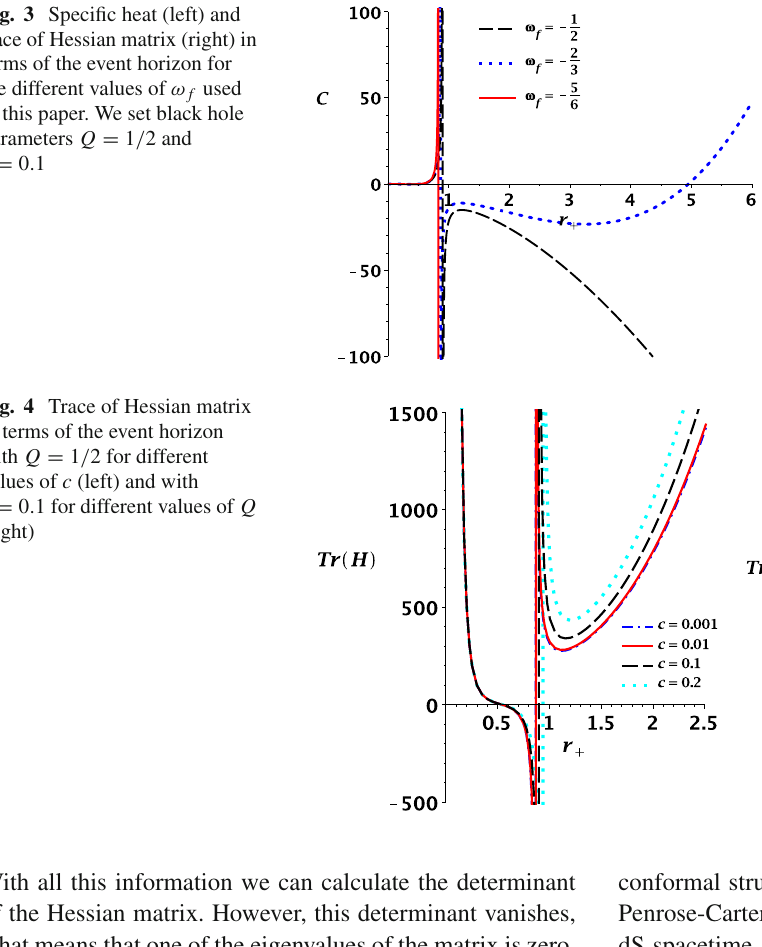
Fig. 3 Specific heat (left) and trace of Hessian matrix (right) in terms of the event horizon for the different values of ω f used in this paper. We set black hole parameters Q = 1 / 2 and c = 0 . 1